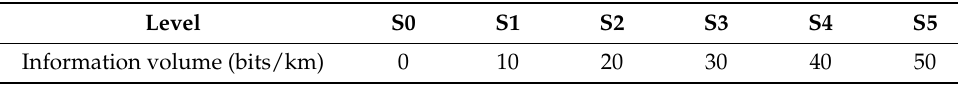
Table 2. The levels of the TSIV in the test